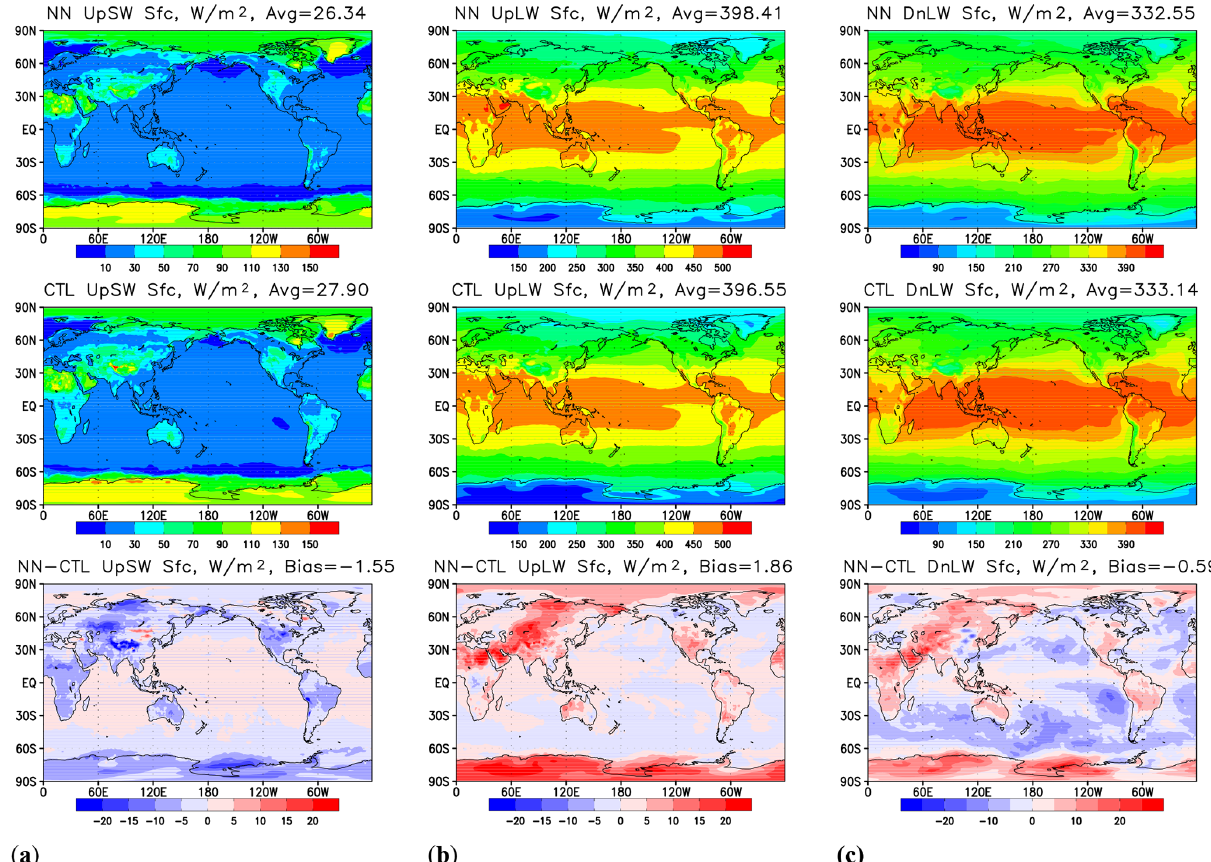
Figure 3. Time means over 12 months’ worth of model output covering 1 February 2018–1 February 2019 for (a) upwelling SW radiation at the surface, (b) upwelling LW radiation at the surface, and (c) downwelling LW radiation at the surface. Upper row – results produced by HGFS; middle – results by GFS; lower row: the difference (HGFS − GFS). Table 2. Time mean and global mean biases in LW heating rate (LWHR), SW heating rate (SWHR), and upwelling (Up) and downwelling (Dn) radiative fluxes at TOA and at the surface (Sfc) over 12 months’ worth of model output covering 1 February 2018–1 February 2019. Variable LWHR SWHR OLR OSR LW Up Sfc LW Dn Sfc SW Up Sfc SW Dn Sfc